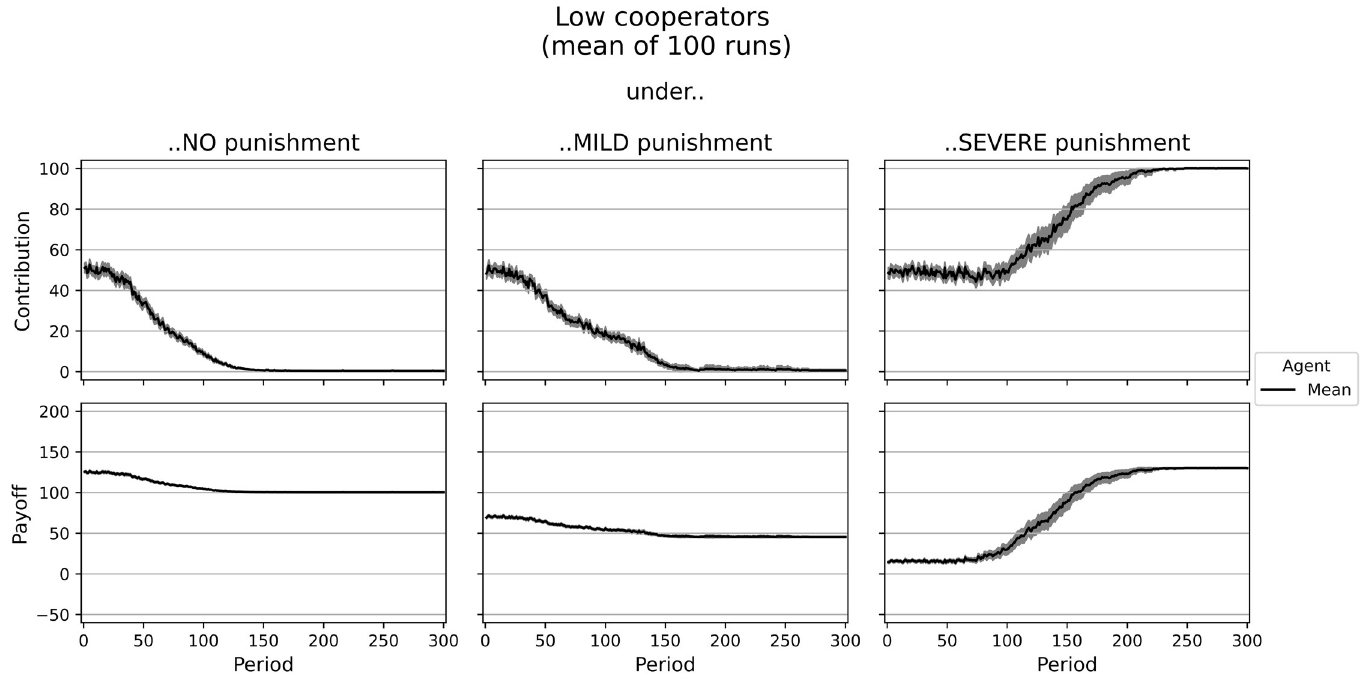
Fig 2. Dynamics of contributions and payoffs of low cooperators under no, mild, and severe punishment. Arithmetic mean of 100 simulation runs. In gray: confidence interval (95%) around the mean.